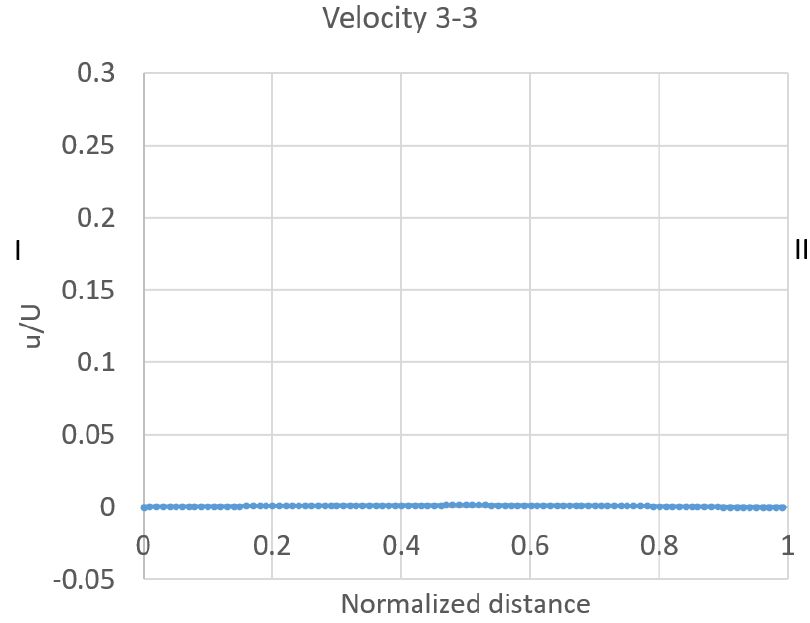
Figure 9. Velocity profile at the center section (2-2).